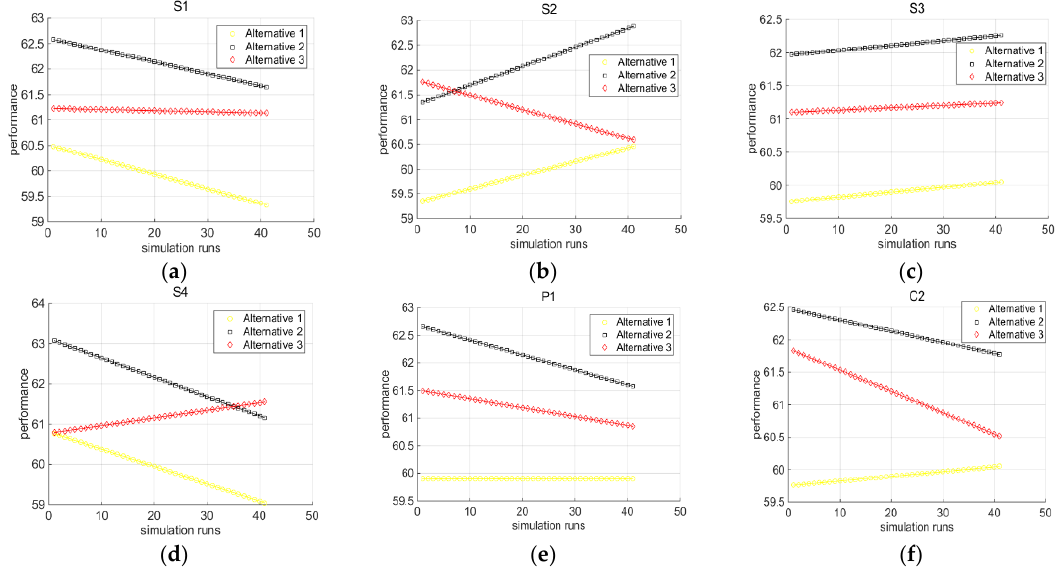
Figure 5. Results of sensitivity analysis results for criteria: ( a ) PEO; ( b ) CHZ; ( c ) CHM; ( d ) TNI; ( e ) ESU; and ( f ) FRC as the main changing criterion.